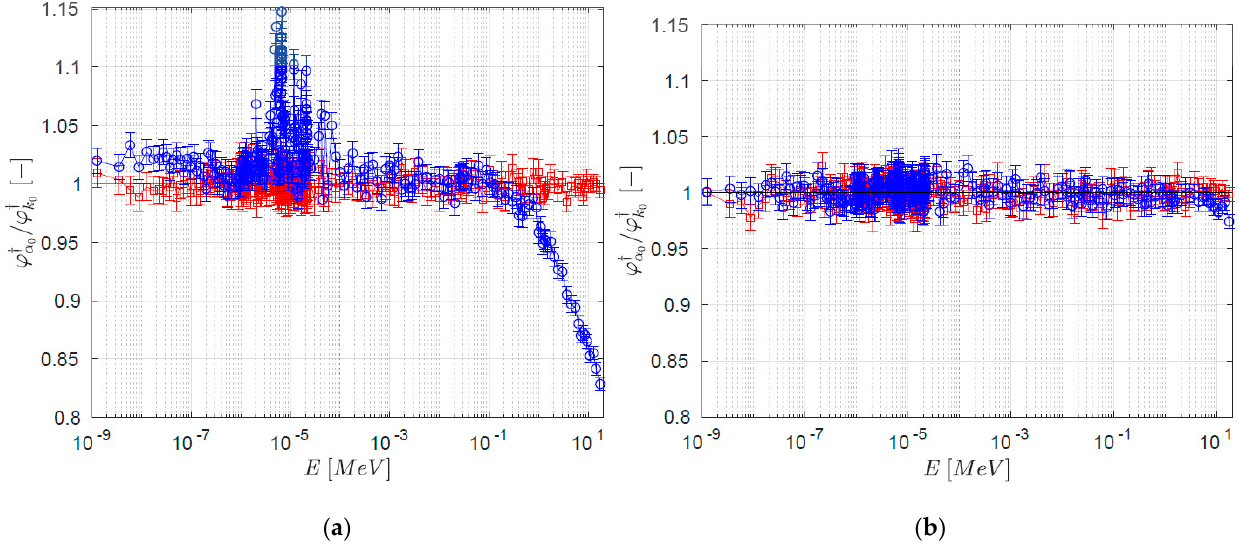
ϕ / ϕ of the adjoint fundamental distributions, for sub-critical ( a ) and super-critical ( b ) † † α k 0 k 0 0 0